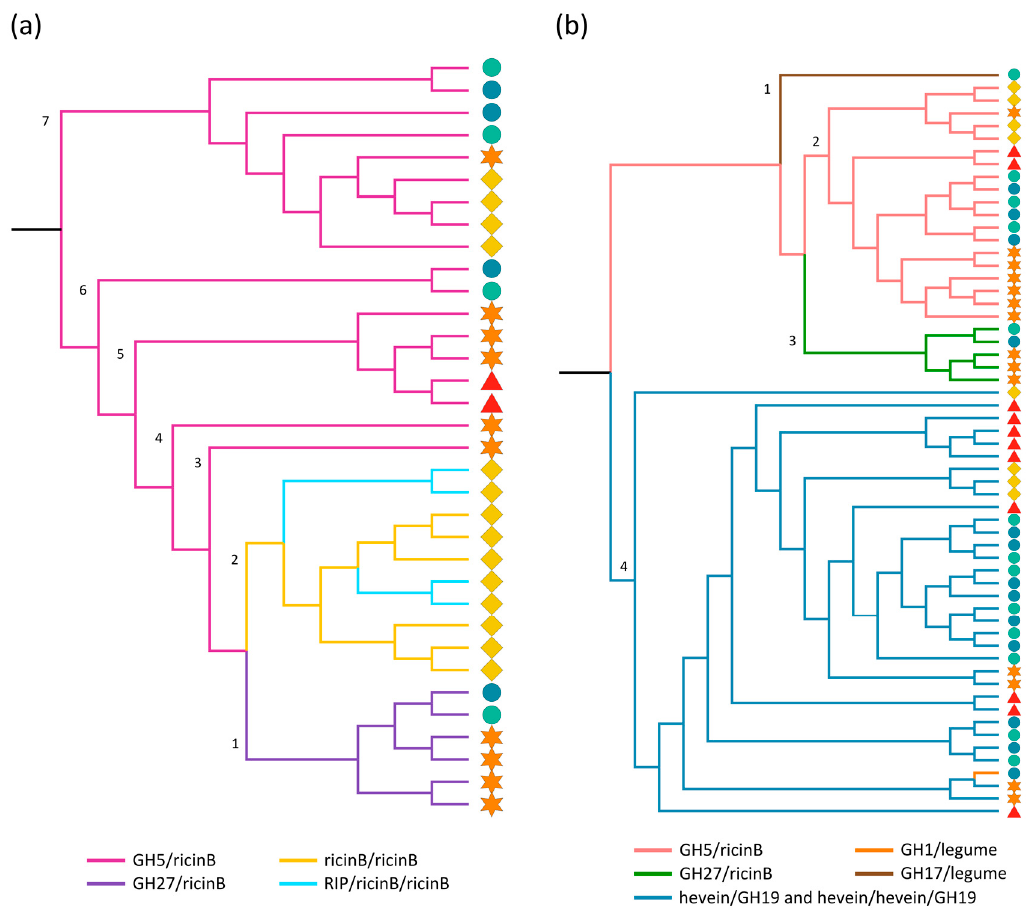
Figure 1. Midpoint rooted cladogram constructed with all ricin B ( a ) and GH ( b ) domain sequences from Arabidopsis (red triangle), soybean (orange star), cucumber (yellow rhomb) and rice ( japonica : green circle, indica : blue circle). Numbers indicate the clade numbers and the colored branches correspond to the different domain architectures of the full-length ricin B ( a ) and GH ( b ) sequences.